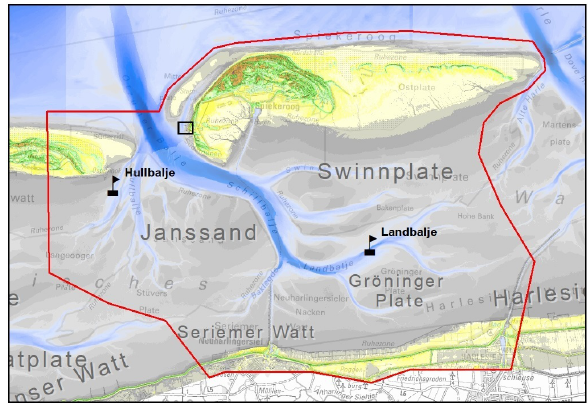
Figure 2. F-SAR surveyed area (red frame) in the German Wadden Sea. The flags indicate the positions of the sea-level gauges. Location of the relevant study site on the western tip of Spiekeroog island (Figure 6) is indicated by a black